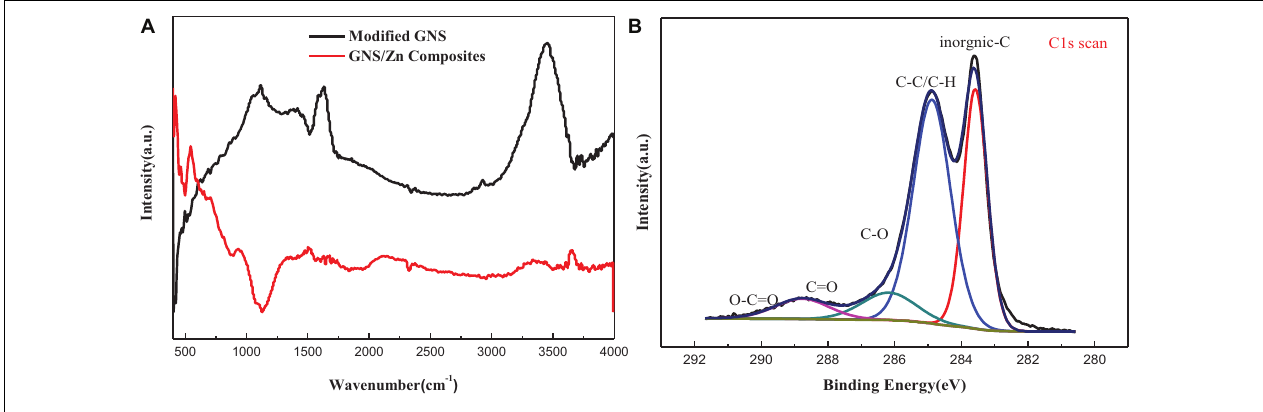
FIGURE 3 | (A) FT-IR spectrum of modified GNS and GNS/Zn composites, (B) XPS spectrum of GNS/Zn composites.